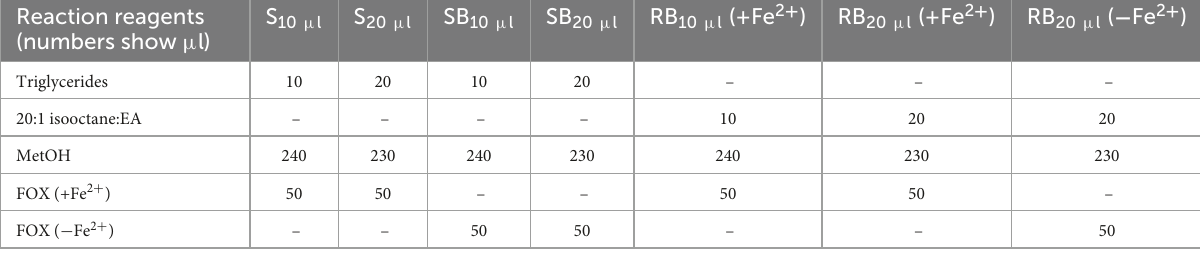
TABLE 2 Assay set up for LOOH determination in LDL triglycerides. Reaction reagents (numbers show µ l)